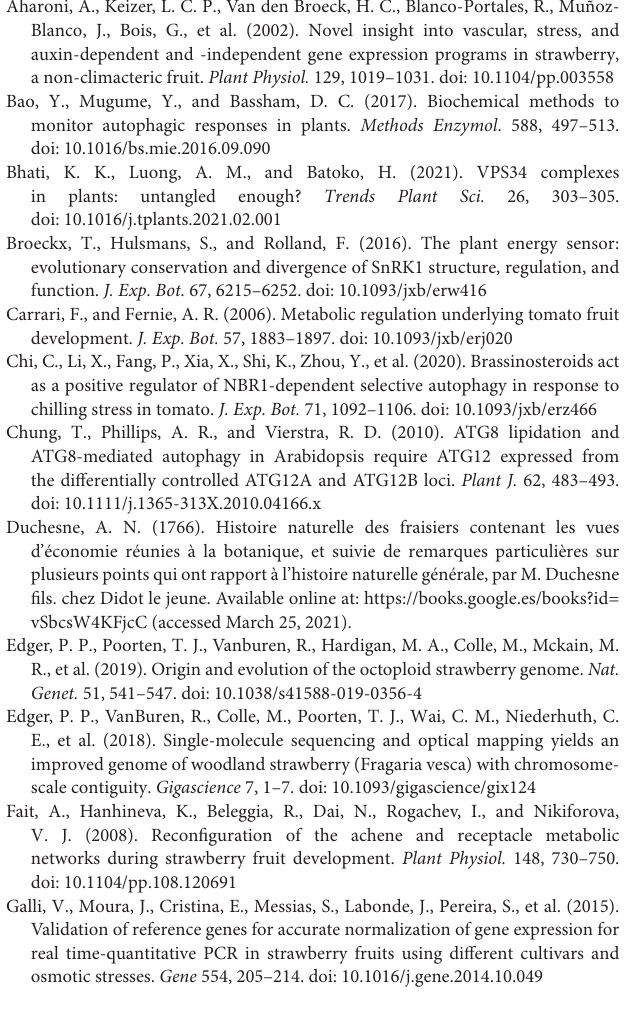
Supplementary Figure 1 | Alignment of FaATG8 aminoacidic sequences. Black and red arrows mark the residues that form the W and L pockets as shown for ATG8 from Brassicales, Solanaceae, and Poaceae (Kellner et al., 2017). Black asterisk marks the conserved Glycine to which PE is bond after ATG8 lipidation. Supplementary Figure 2 | Analysis of autophagy flux in F. x ananassa cv. “Camarosa,” (A) Stages of strawberry ripening in F. x ananassa cv. “Camarosa” analyzed for autophagy flux. (B) Immunoblot of ATG8 showing non-lipidated (ATG8) and lipidated form (ATG8-PE) and immunoblot of NBR1 along ripening. (C) Summatory of all NBR1 homoeologs RNAseq data.